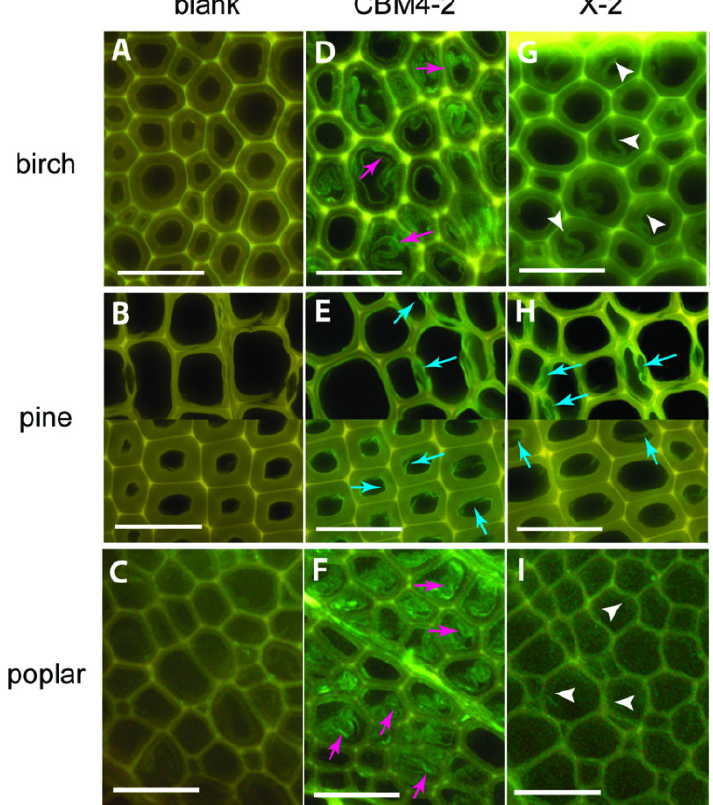
Figure 6. Differences in binding of CBMs to various wood sections: CBM4-2 (D-F) and X-2 (G-I) in birch, pine and poplar. Negative control staining of wood sections (blank, A – C ) with mouse anti-His antibody and FITC-conjugated anti-mouse IgG. Scale bar = 50 µm. Figure from